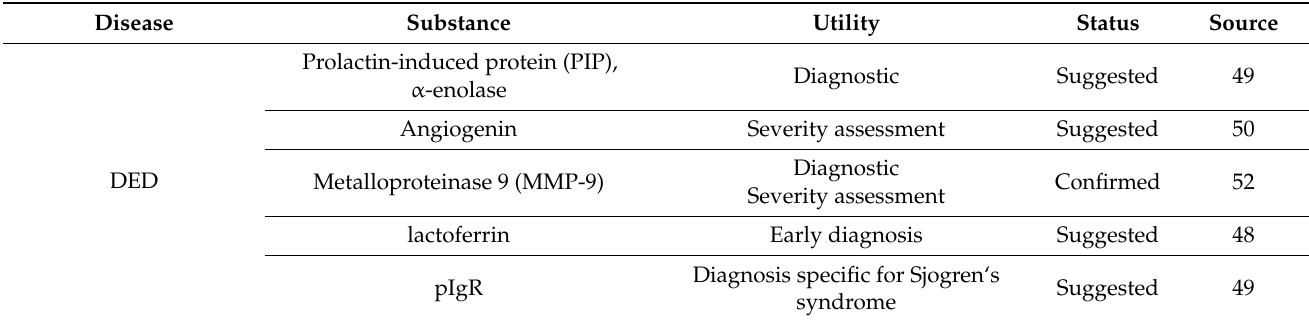
Table 3. Most promising tear biomarker